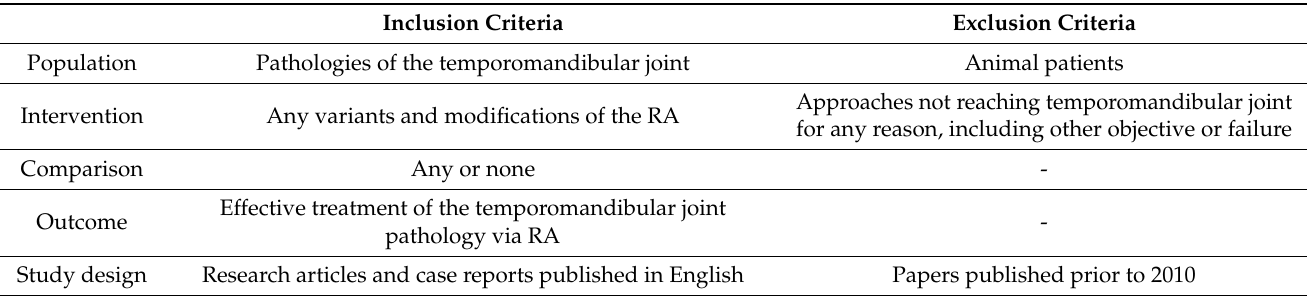
Table 1. Short version of the eligibility criteria. Full description in the